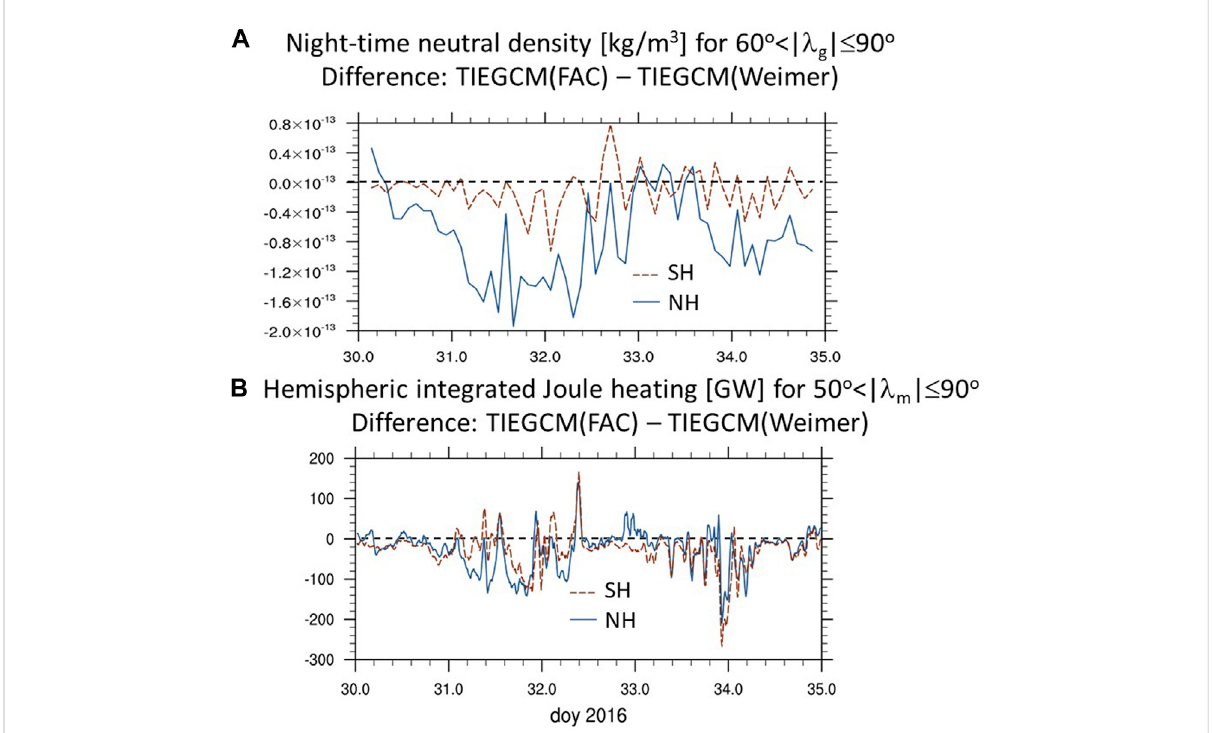
FIGURE 10 Difference of (A) . night-orbit high latitudinal averaged (60 0 < | λ g | ≤ 90 0 ) neutral density [ kg / m 3 ] between TIEGCM(FAC) and TIEGCM(Weimer) and (B) .of height and high latitudinal integrated (50 0 < | λ m | ≤ 90 0 )Jouleheating rate [GW] between TIEGCM(FAC) and TIEGCM(Weimer)for northern hemisphere (blue solid line) and southern hemisphere (orange dashed